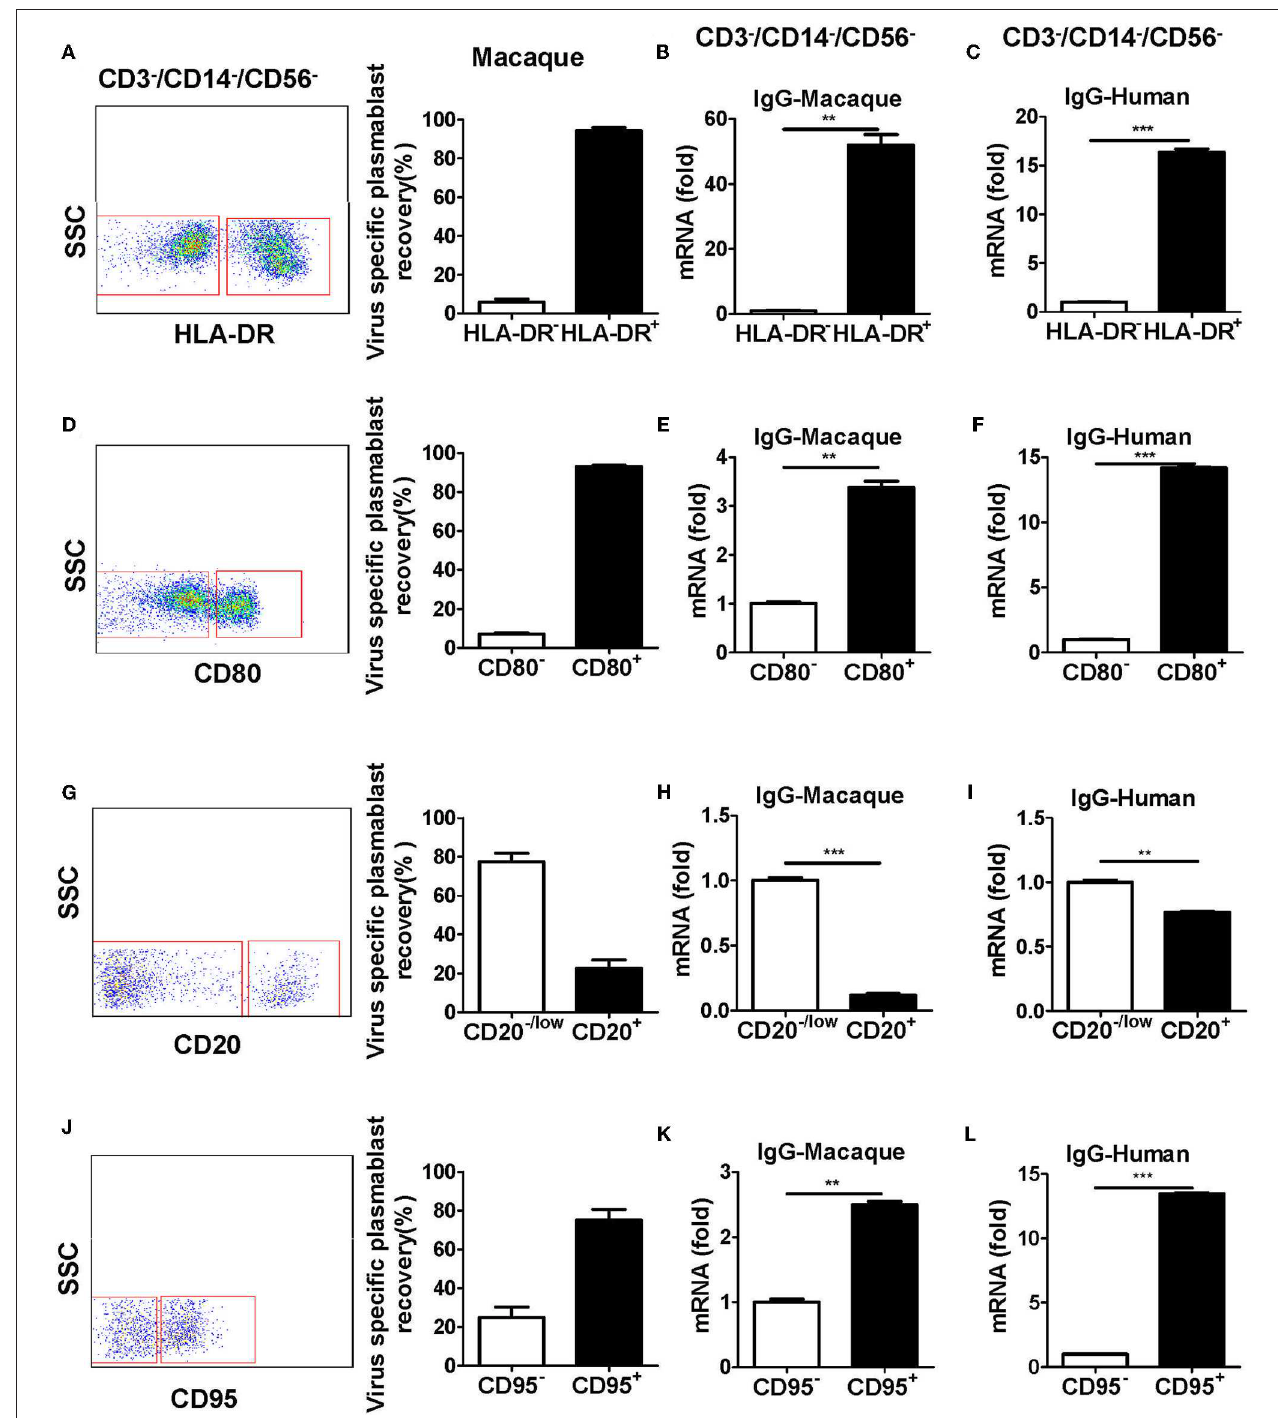
FIGURE 4 | Antibody-secreting plasmablasts from Chinese rhesus macaques are CD3 − CD14 − CD56 − CD19 − CD27 − CD20 − / low CD80 + HLA-DR + CD95 + cells. PBMCs from rhesus macaques ( n = 4) were sorted from among the CD3 − CD14 − CD56 − CD19 − subset cells based on the positive or negative expression of HLA-DR (A) , CD80 (D) , CD20 (G) , or CD95 (J) and subsequently subjected to influenza virus-specific ELISPOT assay. Values represent the mean percentage of total Ig-secreting plasmablasts recovered from each cell population (Mean ± SEM). PBMCs from Chinese rhesus macaques ( n = 4) and human volunteers ( n = 3) were sorted from among the CD3 − CD14 − CD56 − cells based on the positive or negative expression of HLA-DR (B,C) , CD80 (E,F) , CD20 (H,I) , or CD95 (K,L) and qRT-PCR was used to assess the mRNA expression levels of IgG. The experiment has repeated a minimum of three times. ** P < 0.01; *** P < 0.001.